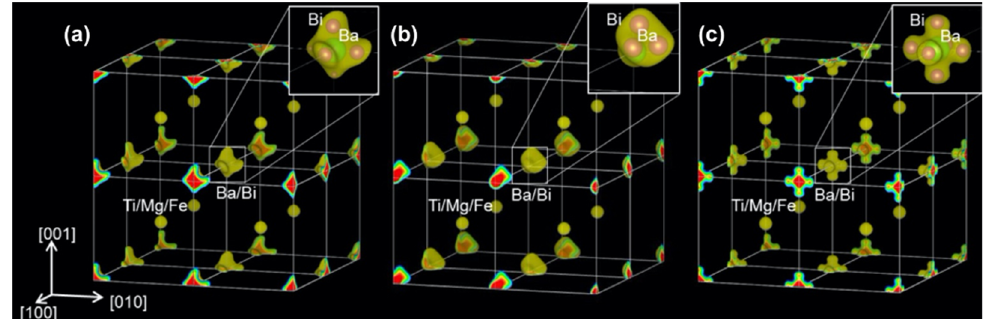
Figure 22. Electron density distribution of 0.30BaTiO 3 –0.10Bi(Mg 1/2 Ti 1/2 )O 3 –0.60BiFeO 3 at ( a ) 300 K, ( b ) 600 K, and ( c ) 900 K. Reprinted with the permission of [152]. Copyright © 2021 Springer Nature.